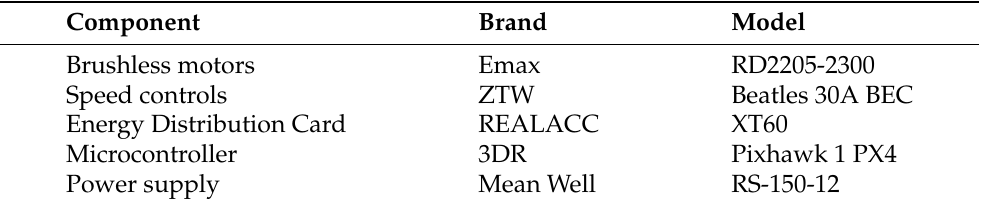
Table 3. Electronic components specifications.